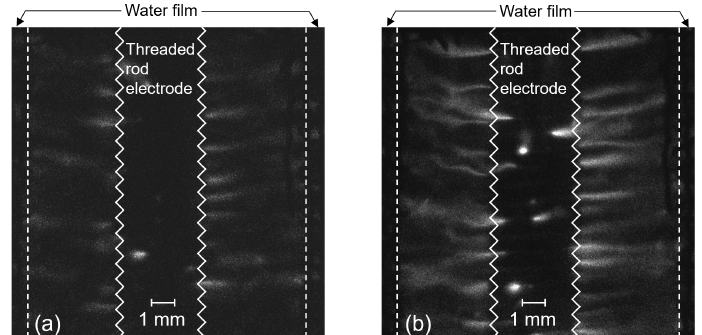
Figure 4. Pulsed streamer discharges taken by an intensified charge-coupled device (ICCD) camera. ( a ) Exposure time: 5 ns. ( b ) Exposure time: 100 ns. The pulsed streamers were driven by nanosecond- pulsed voltage, whose peak value and repetition frequency were 24 kV and 100 pps, respectively, while tap water was circulated with a flow rate of 500 mL/min.